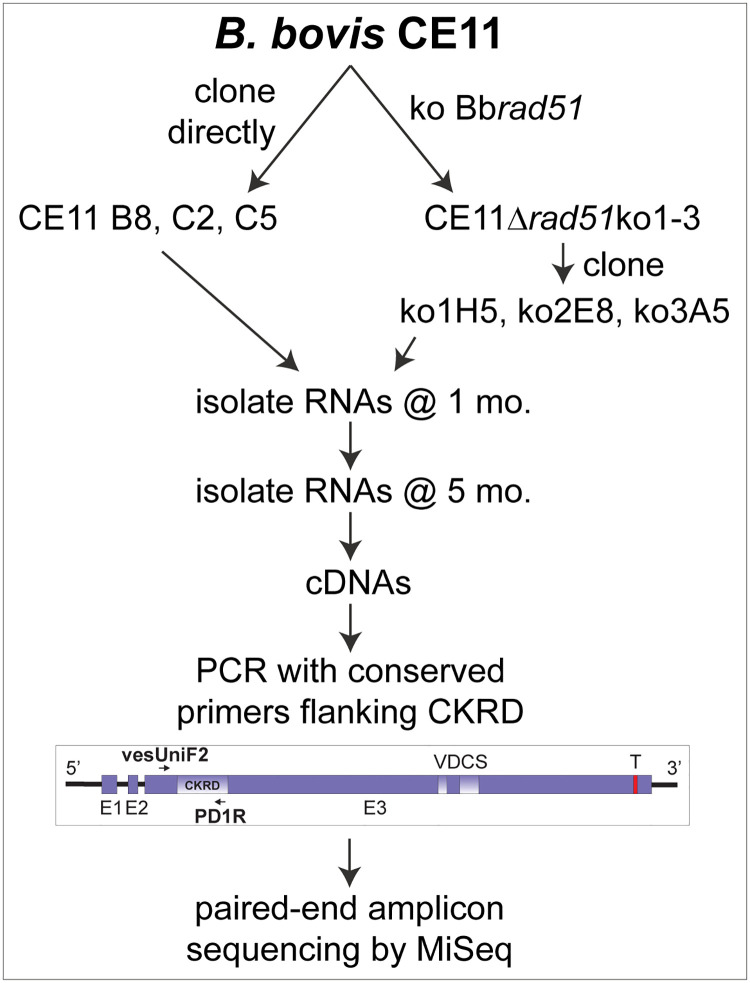
Flow of the assay for SGC characteristics.For this experiment, B. bovis CE11 was directly subcloned to provide clonal lines CE11B8, CE11C2, and CE11C5. Three independent Bbrad51 knockout lines were created and cloned, giving rise to clonal lines ko1H5, ko2E8, and ko3A5. Total RNAs were collected at 1 month and 5 months post-cloning, and used for cDNA generation. The primer pair vesUniF2 and PD1R flanking the highly variant CKRD domain were used to PCR-amplify transcribed ves1α transcripts. Amplicons were used to generate paired-end libraries for sequencing by Illumina MiSeq. Unique recombinant sequences were identified bioinformatically. Details for all aspects are found in Methods.